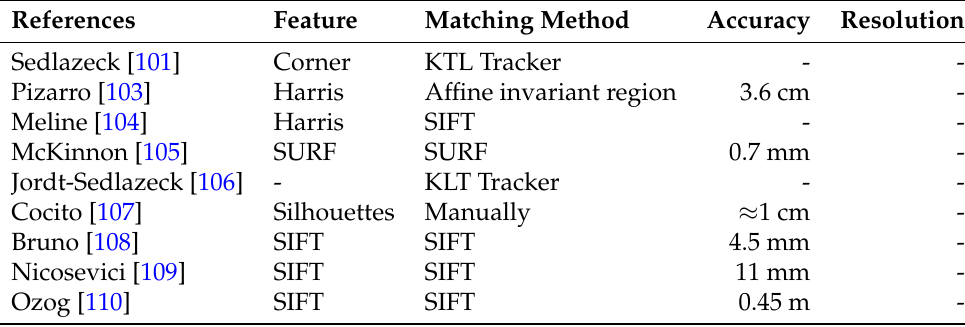
Table 5. Summary of structure from motion 3D reconstruction